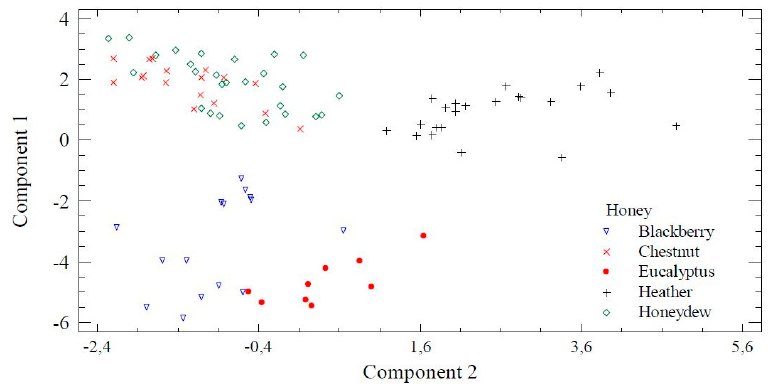
Figure 4. Plot of the first two components of PCA with the dispersion of samples by honey type.